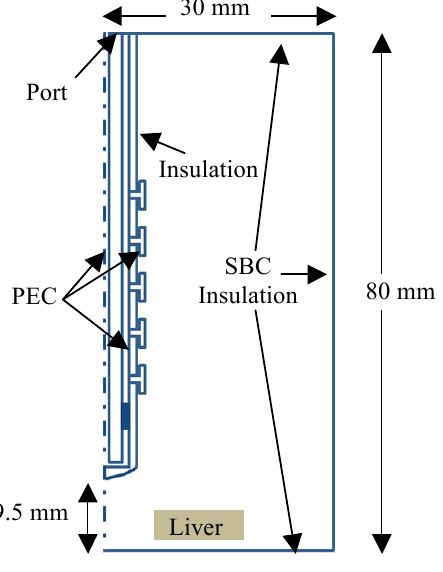
Figure 4: Model Geometry and Boundary Conditions